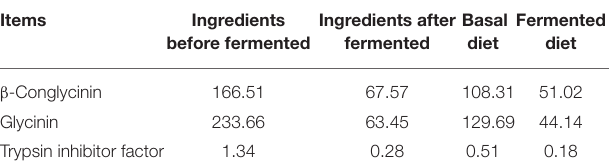
before fermented